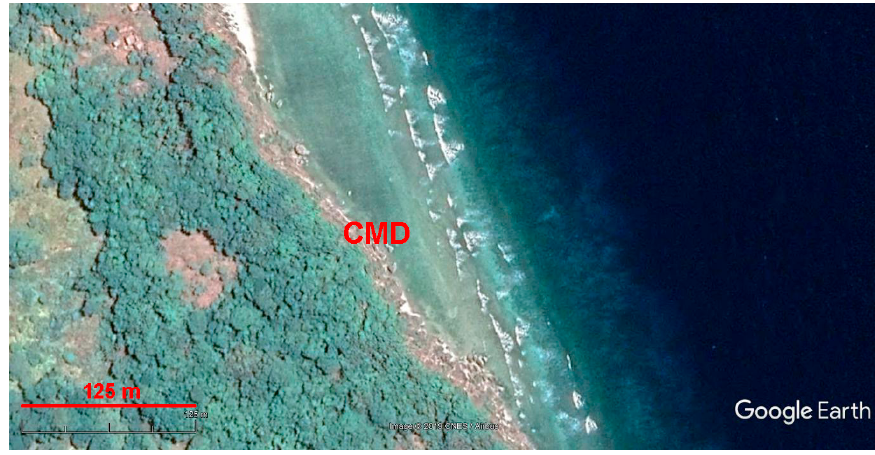
Figure 6. The eastern plot of the Wetar Island locality (the view provided by the Google Earth Engine).